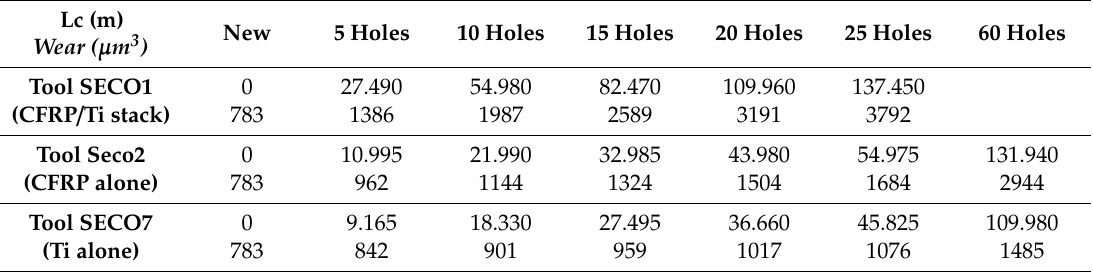
Table 3. Evolutions of the drill wear in the di ff erent materials (for one cutting